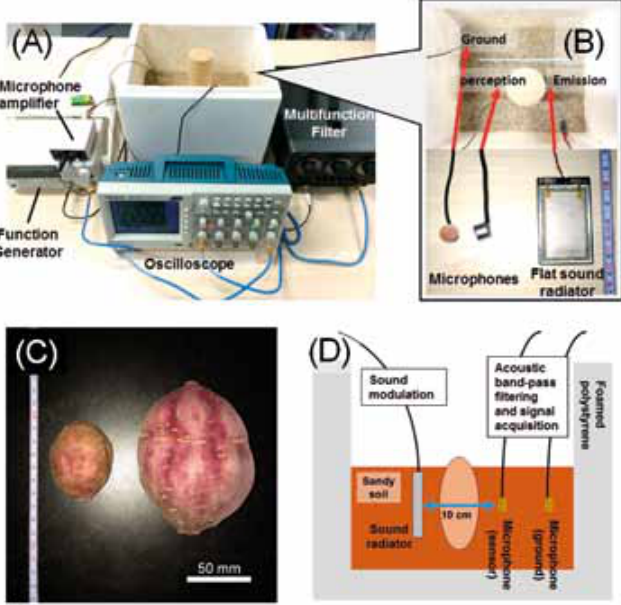
Fig. 1 - Equipment for the acoustic sensing of belowground plant tissues. (A) Experimental configuration. Modulation and demodulation of acoustic signal propagated in a sandy soil bed were preliminar- ily tuned with and without wooden stick. (B) A pair of acoustic probes designed for emitting and receiving the modulated and band-pass filtered sound signals in the soil or sand. Left, sens- ing and reference microphones. Right, flat-shaped sound radiator with directional sound propagation. (C) Sweet potato tuberous roots used for demonstration. (D) Experimental